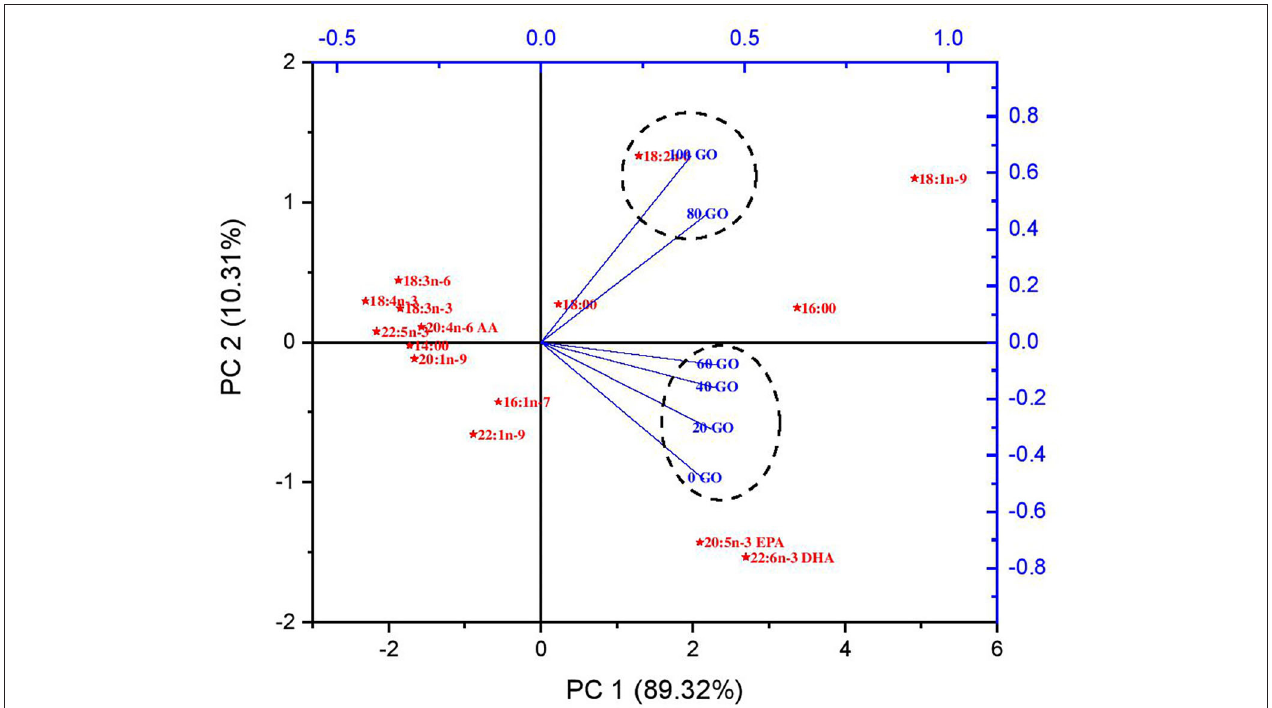
FIGURE 1 | Principal component analysis of muscle fatty acids of rohu fingerling fed on different experimental diets.